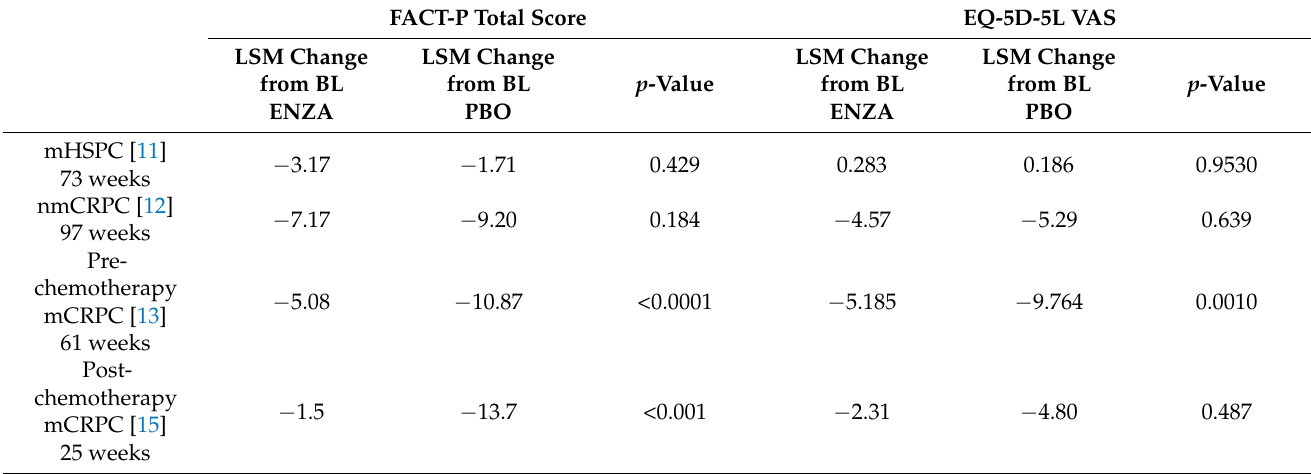
Table A5. Change from BL in HRQoL